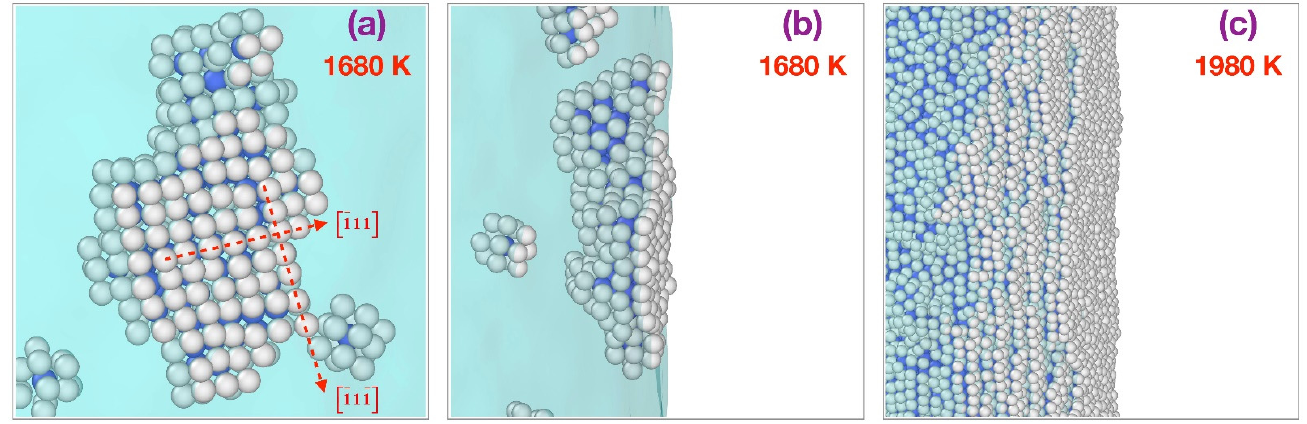
Figure 2. Close-up view (perspective projection) of the crystal grain marked as “X” in Figure 1a,f at 1680 K ( a , b ) and 1980 K ( c ). Blue: BCC atoms; Gray: BCC shell atoms.